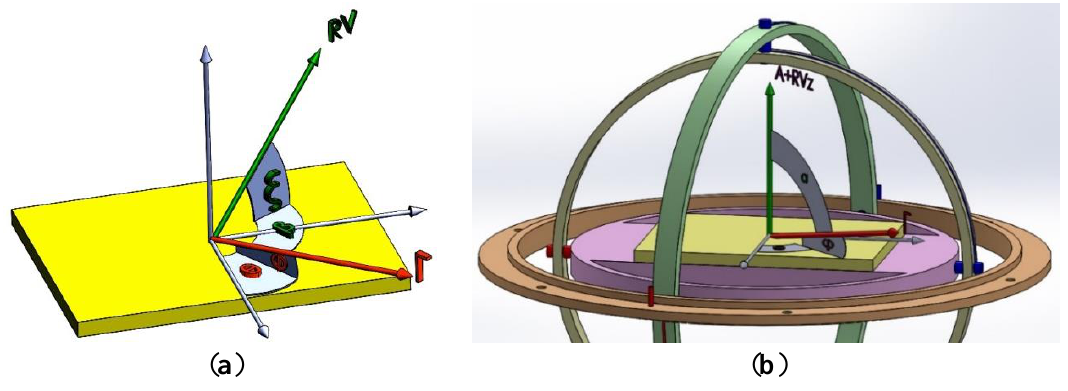
Figure 20. Random vibration applied on crystal oscillator 0 < |ξ| < π, 0 < |β| < π. ( a ) Fixed oscillator; ( b ) Oscillator on gyroscopic mounting.